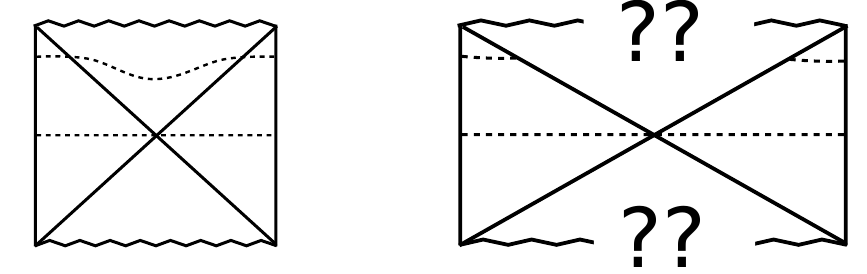
Figure 3 . Sketch of a Penrose diagram with dashed lines indicating the symmetric space-like geodesics for t = 0 and t 6 = 0. The diagram on the left is for the BTZ black hole, the one on the right for the state we are investigating.